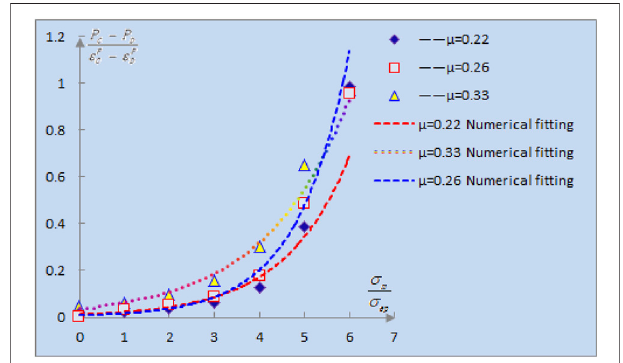
FIGURE 13 | Ductile damage of rock under different loading rates and Poisson ’ s